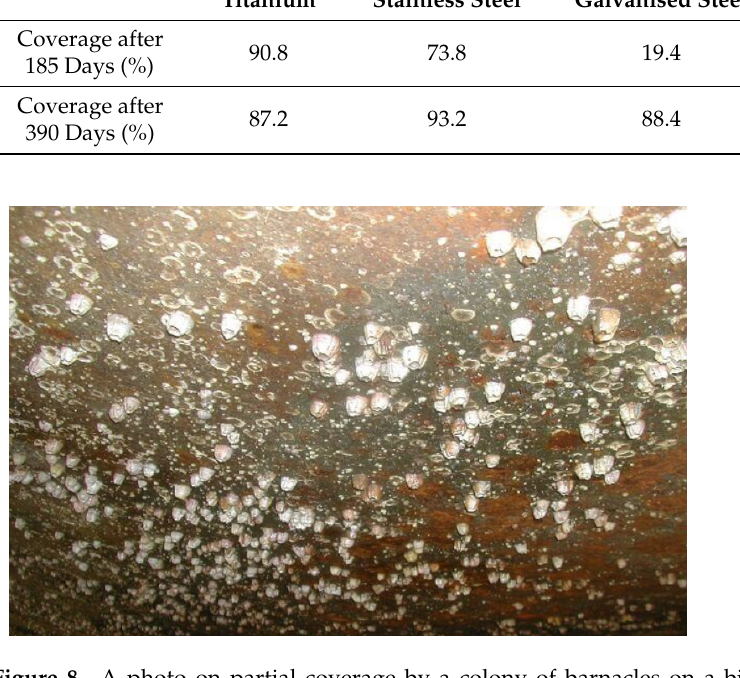
Figure 9. Evolution of drag coefficient ( C D ) as a function of biofouling coverage ratio for different surface roughness values ( k ) and biofouling type (adapted from [31]). Some researchers have investigated the drag coefficient as a linear regression func- tion of the thickness and roughness [65]. Güven et al. [50] reported that when the rough- ness grew larger than the thickness of the boundary layer a thicker and more retarded boundary layer was formed. The roughness effect on the flow depends on the relative size of the roughness to the boundary layer thickness, which is different from the effect of the relative size of the roughness to the cylinder diameter [66]. According to API [6], an addi- tional parameter that affects the drag coefficient of elements with circular cross-sections is the effective diameter (Figure 1a). By growing the thickness of biofouling, the effective diameter of the cylinder changes with time [67,68]. To calculate the effective diameter values, it should be assumed that cylinders surfaces or at least a substantial part of them are completely covered with bio- fouling. In cases where the surface coverage ratio experiences a lower percentage of bio- fouling, especially if the coverage percentage is less than 50%, this definition should be